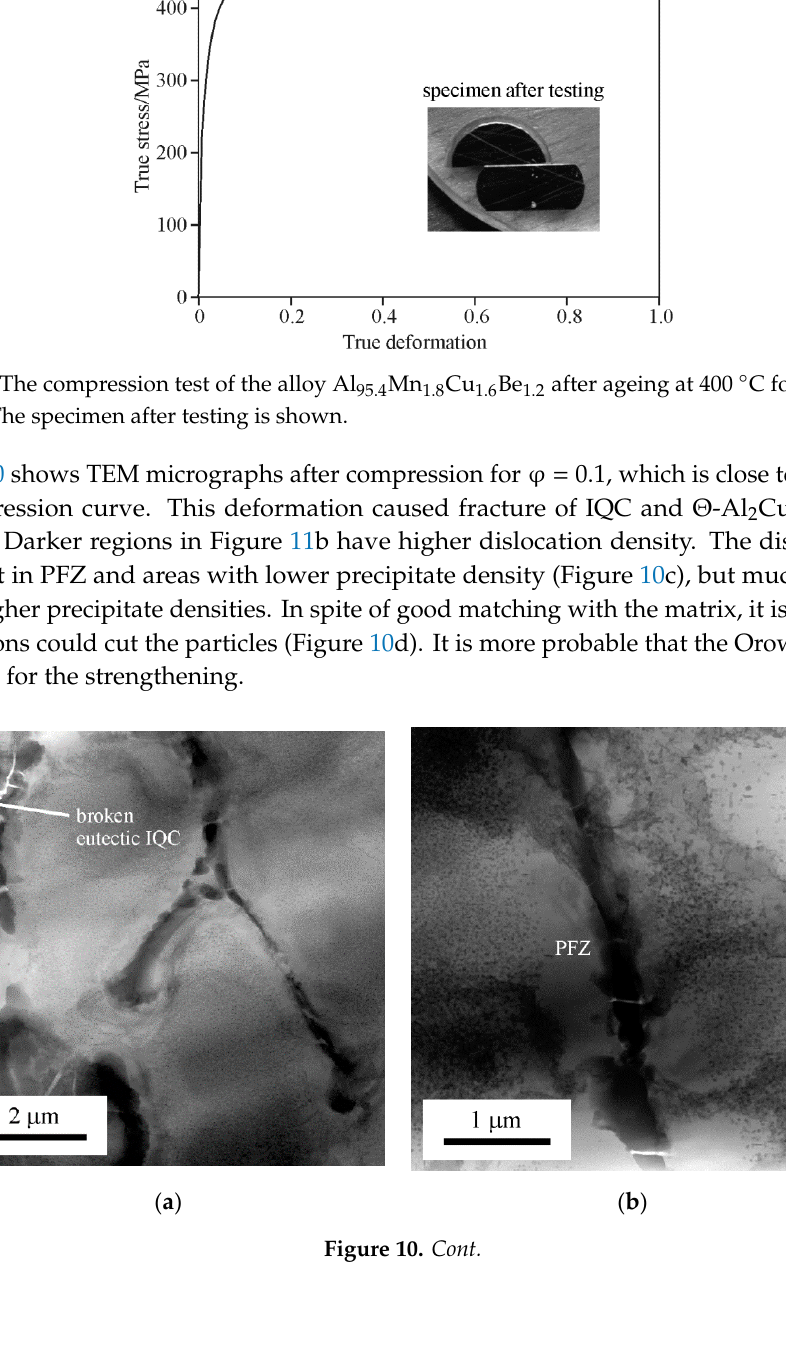
Figure 9. The compression test of the alloy Al 95.4 Mn 1.8 Cu 1.6 Be 1.2 after ageing at 400 °C for 1 h, 6 mm sample. The specimen after testing is shown.